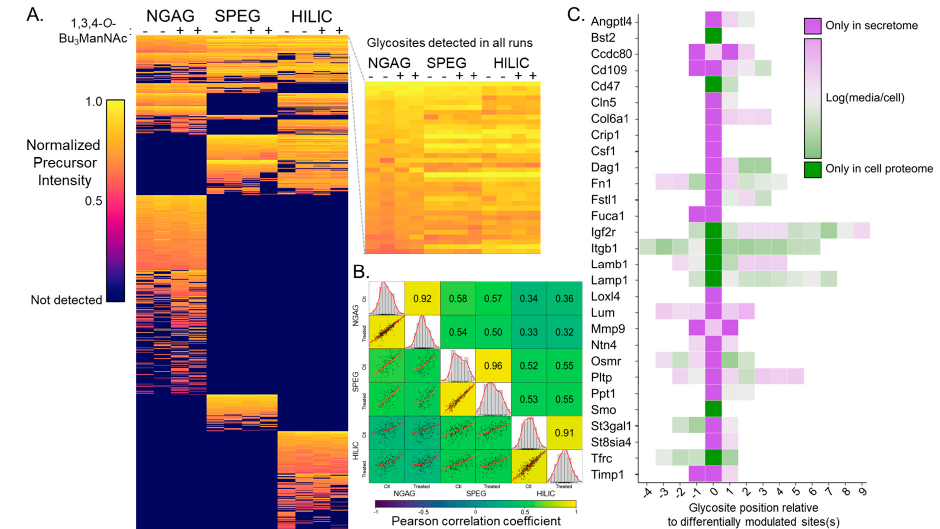
Figure 3. Secretome glycosite quantification by precursor intensity. ( A ) Heatmap showing normalized precursor intensities of all 953 glycosite-containing peptides from each biological replicate from untreated control ( − ) and 1,3,4- O -Bu 3 ManNAc treated (+) samples identified by NGAG, SPEG, and HILIC. Dark blue coloring indicates a glycosite that was not detected in a particular replicate. Glycosites are ordered by the degree of overlap between the three approaches and from high precursor intensity to low. Inset depicts the 35 glycosites that were detected in all replicates to demonstrate the level of agreement between enrichment workflows. ( B ) Correlation matrix of both treated and control conditions, with replicates averaged, for NGAG, SPEG, and HILIC workflows. The top right portion contains the Pearson correlation coe ffi cients for the intersecting conditions, the middle diagonal depicts the distribution of each condition, and the bottom left portion contains scatterplots for the intersecting conditions with a fitted line. Overall, higher correlation was observed between the results of the same workflow from di ff erent treatment samples, with notably lower correlation between NGAG and HILIC results. ( C ) Heatmap showing the Log(media / cell) values for 29 proteins (along the y -axis) that contained 34 glycosites observed only in cell proteome or only in secretome samples by both SPEG and HILIC analyses. The x -axis shows the position of each glycosite within the protein, relative to those observed only in cell proteome or the secretome which was assigned a position of ‘zero’. For several proteins that contained two glycosites in only the cell or secreted proteome, these multiple sites are centered around a zero position. The values are Log ratios of the mean taken from SPEG and HILIC precursor intensities, with glycosites observed in only cell or only secretome assigned nominal values for